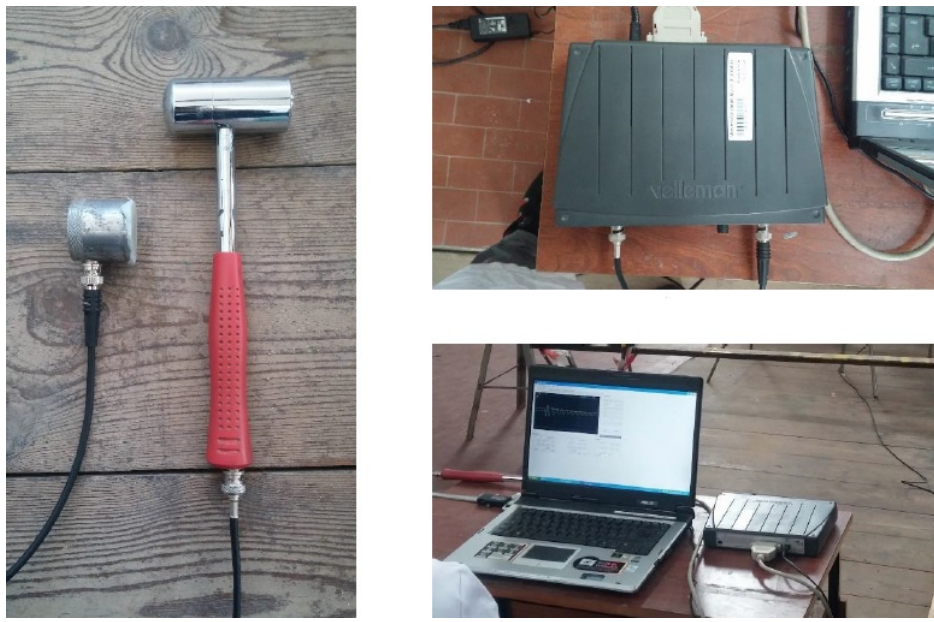
Figure 2. Instrumental set.